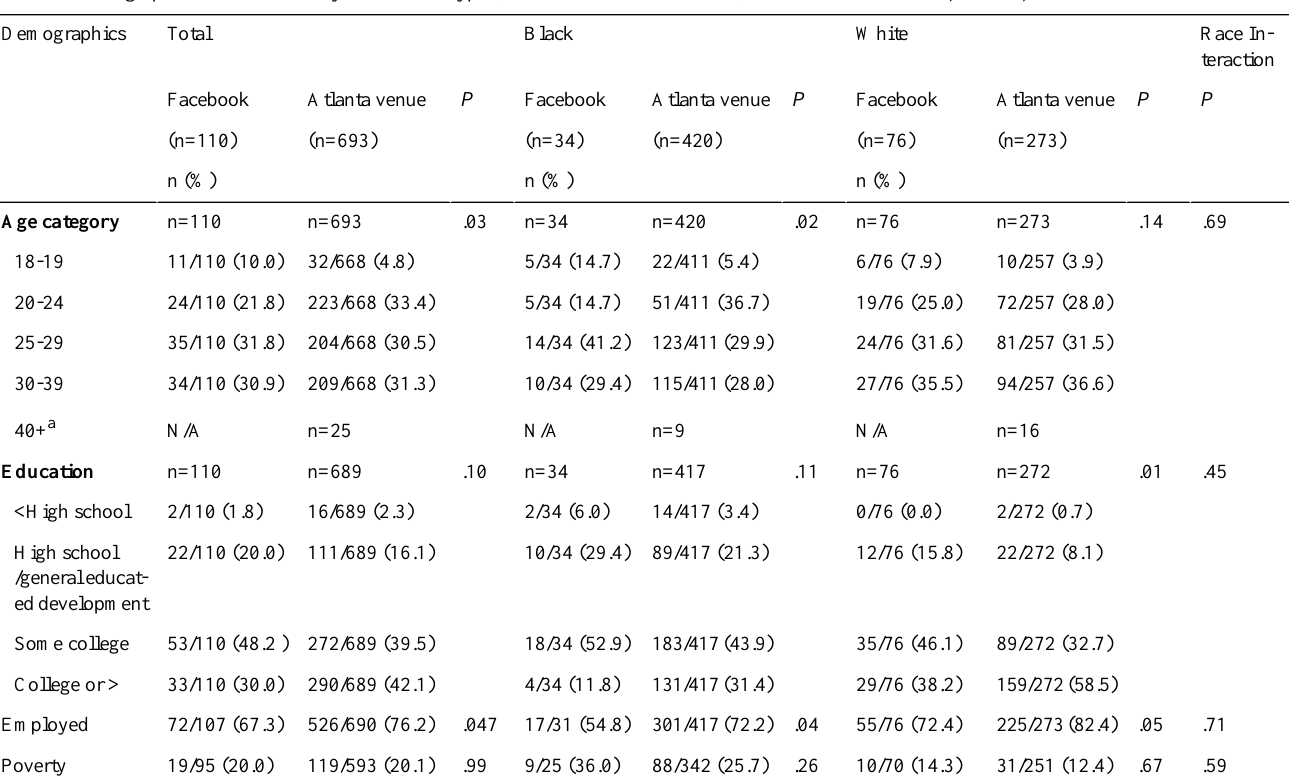
Table 2. Demographic characteristics by recruitment type (Facebook vs Atlanta Venues) and race InvolveMENt, Atlanta,